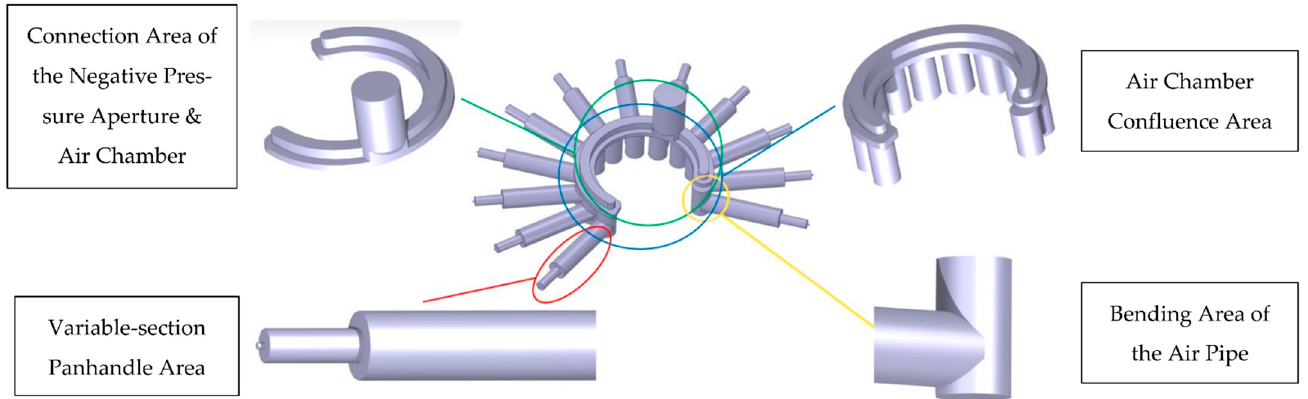
Figure 2. Fluid domain division.